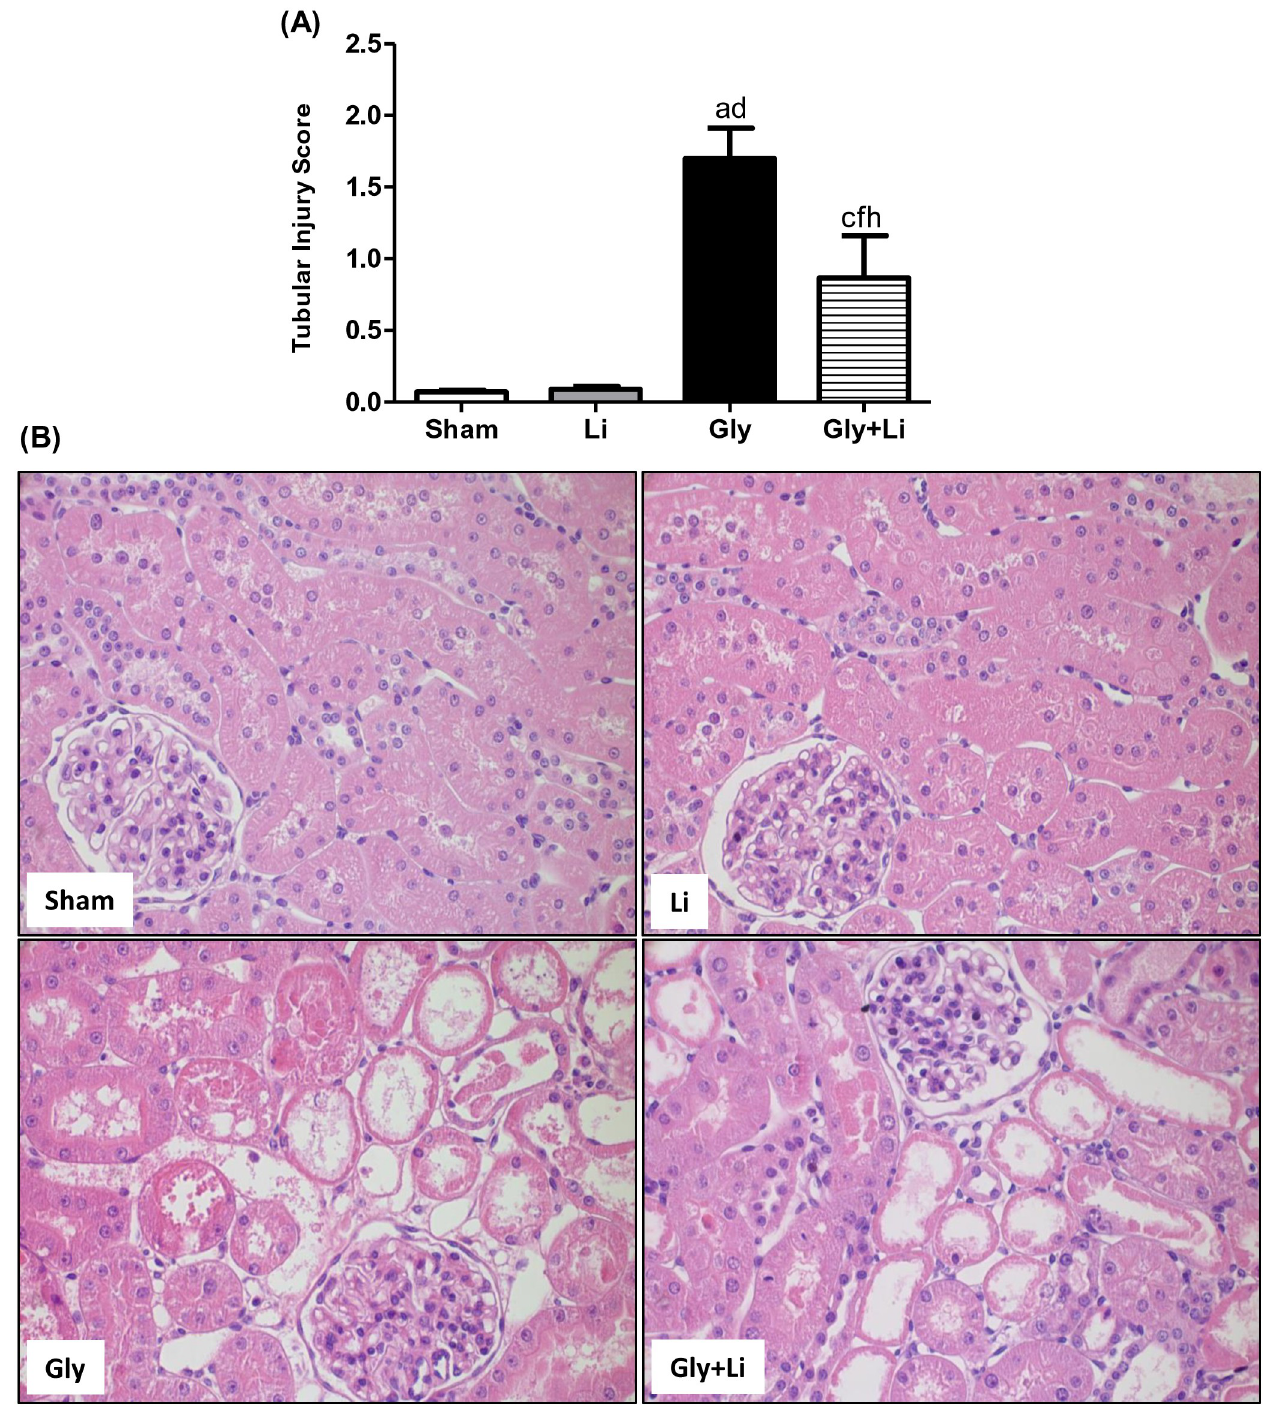
Fig 1. Tubular injury score in the renal cortex evaluated at the end of the 24h protocol. (A) Bar graph of tubular injury score values. (B) Representative photomicrographs of renal histological changes from a Sham, Li, Gly and Gly+Li rat (x400). Values are means ± SEM. a p < 0.001, c p < 0.05 vs. Sham; d p < 0.001, f p < 0.05 vs. Li; h p < 0.01 vs. Gly. Li, lithium; Gly, glycerol; Gly+Li, glycerol + lithium.